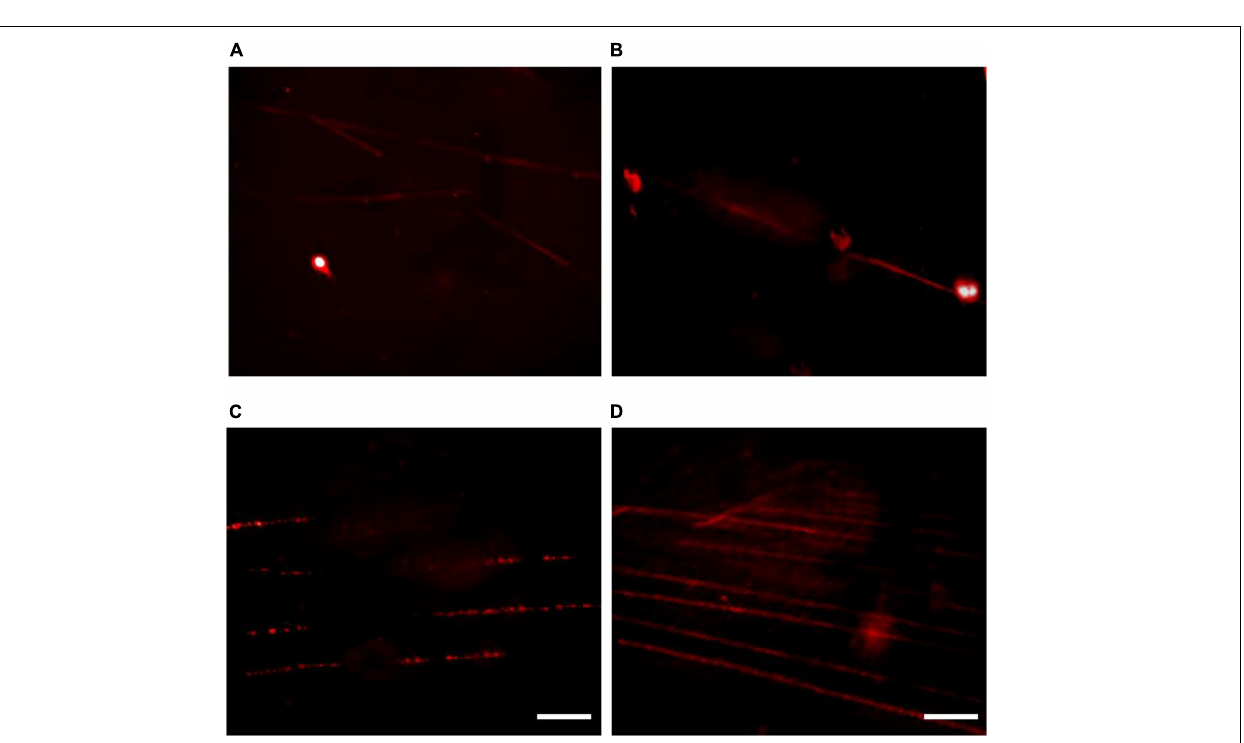
FIGURE 4 | The effect of incubation time on fiber-fluorescence in situ hybridization results in kiwifruit. The incubation time of 10 (A) , 15 (B) , 25 (C) , and 20 (D) min were compared. The white scale bar represents 5 µ m.